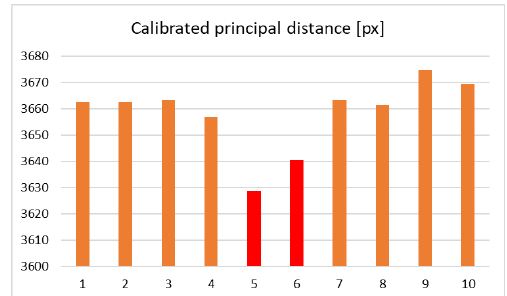
Figure 13. Variations of principal distance for different flights